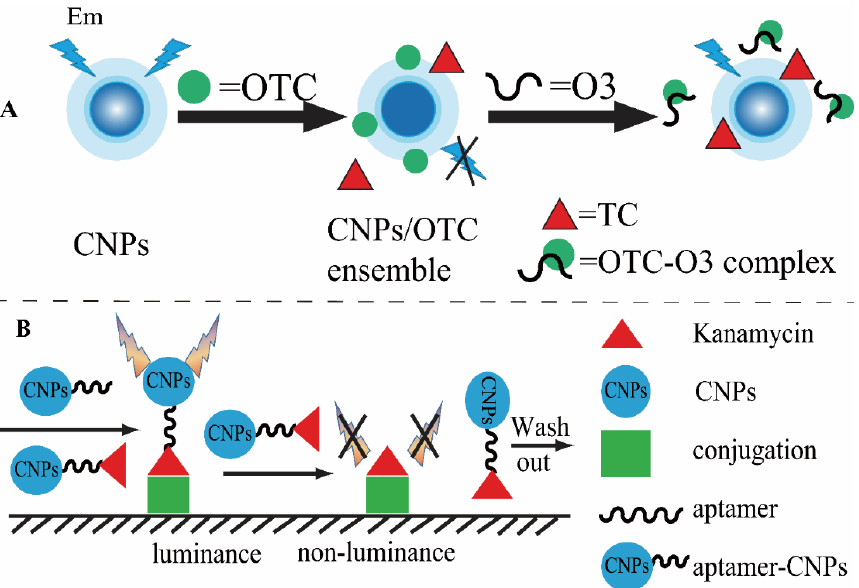
Figure 6. Carbon nanoparticle-based fluorescence methods for the determination of antibiotics. ( A ) Competitive analysis for oxytetracycline, based on aptamer and carbon nanoparticles [48]. ( B ) Mi- croplate-based fluorescence method for kanamycin detection based carbon nanoparticles